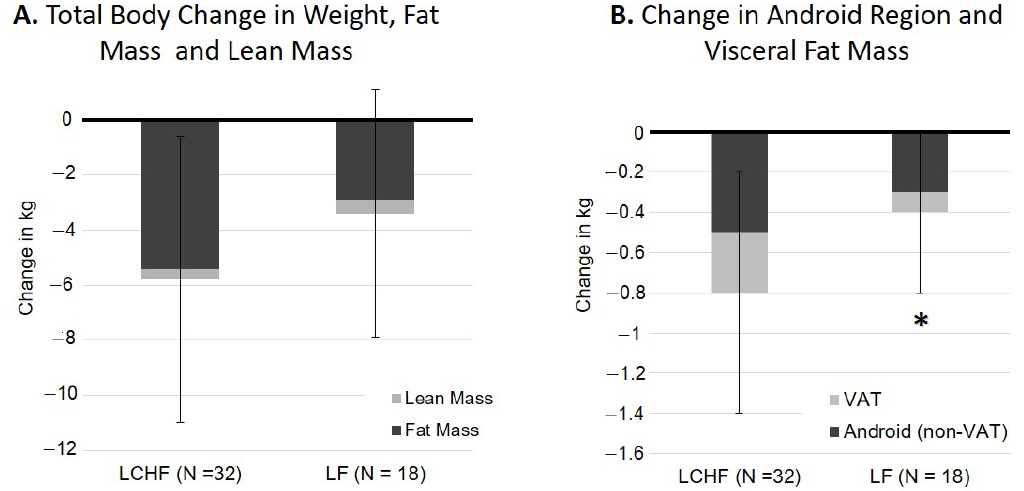
Figure 1. Age, sex, and race, adjusted comparison of change in body composition by diet group. ( A ) Change in weight (total bar), fat mass (dark-filled segment) and lean mass (light-filled segment). ( B ). Change in android region fat mass (total bar), non-visceral android fat (dark-filled segment) and visceral fat (VAT) mass (light-filled segment). Compared to the Low-carbohydrate high fat (LCHF) group, the low-fat (LF) had lower changes in android regions and visceral fat. * ( p <